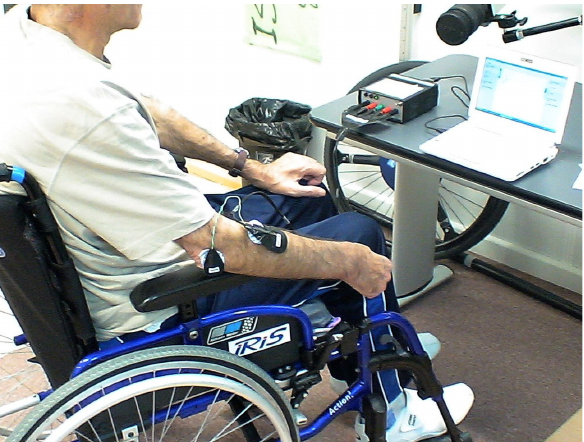
Figure 2. Patient working with the UVa-NTS platform. Surface EMG electrodes were located on the forearm: On the flexor carpi radialis, on the extensor carpi radialis, and the reference electrode was on the